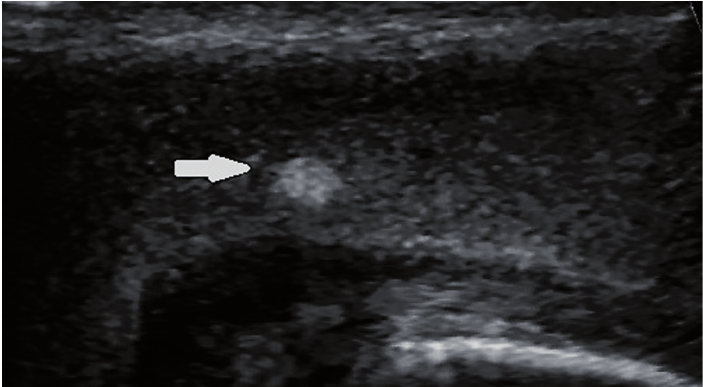
Figure 2 - Longitudinal US image obtained along the ventral aspect of the penis shows a slightly hyperechoic thickening of the intercavernosus septum without acoustic shadow